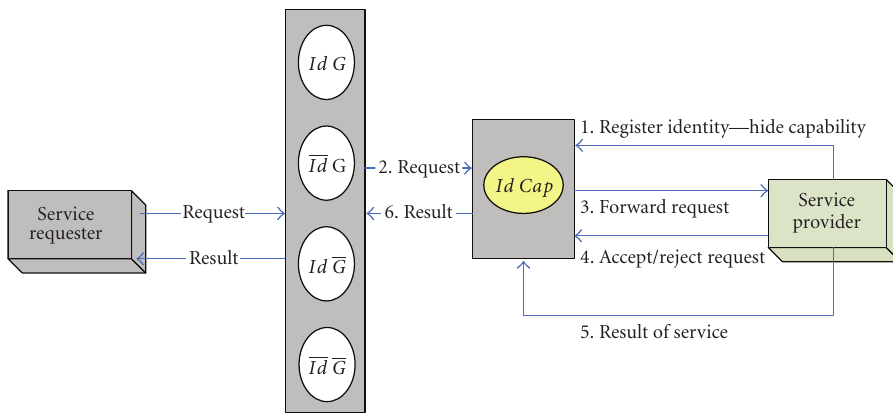
Figure 6: Interaction pattern for providers revealing privacy